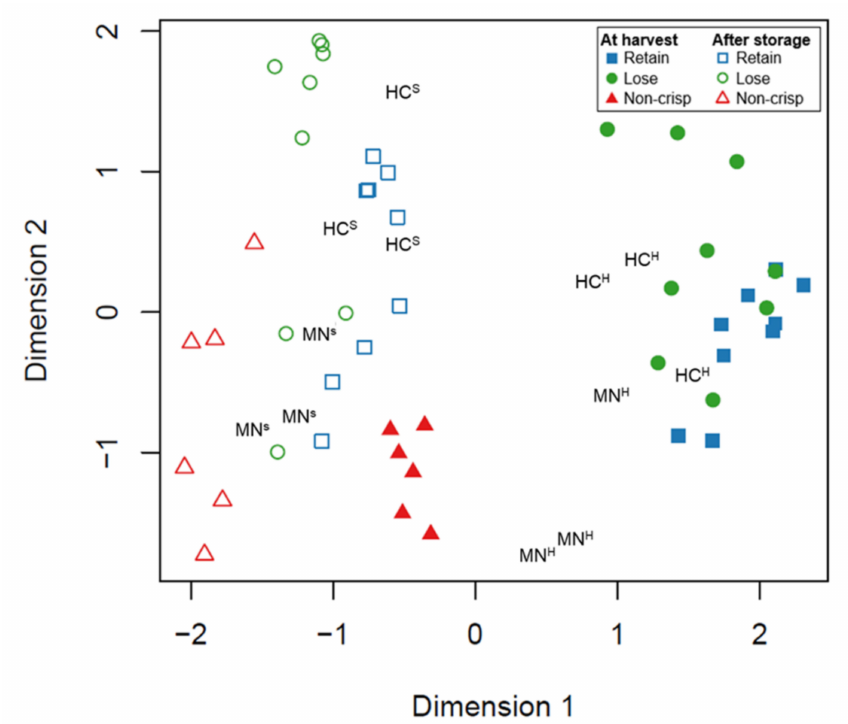
Figure 2. Multidimensional scaling (MDS) plot based on the expression levels of the top 500 most divergent genes. The distance between each pair of samples is the root-mean-square deviation for the top genes. HC H = ’Honeycrisp’ at harvest, HC S = ’Honeycrisp’ after 8-week cold storage, MN H = MN1764 at harvest, MN S = MN1764 after 8-week cold storage. Each symbol represents a replicate